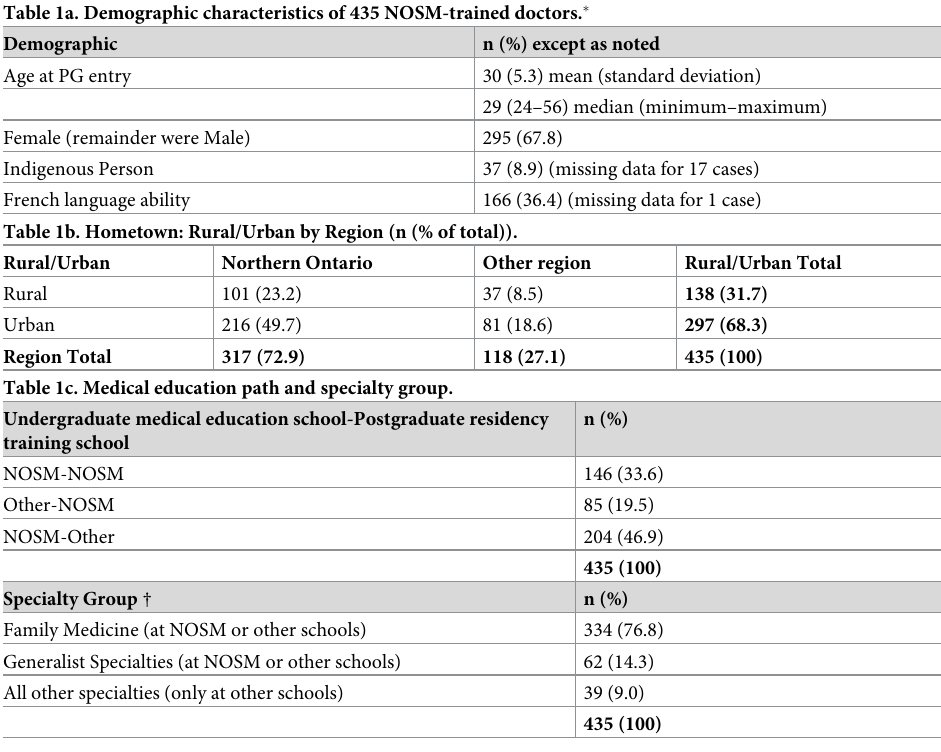
Table 1. Table 1a. Demographic characteristics of 435 NOSM-trained doctors. �